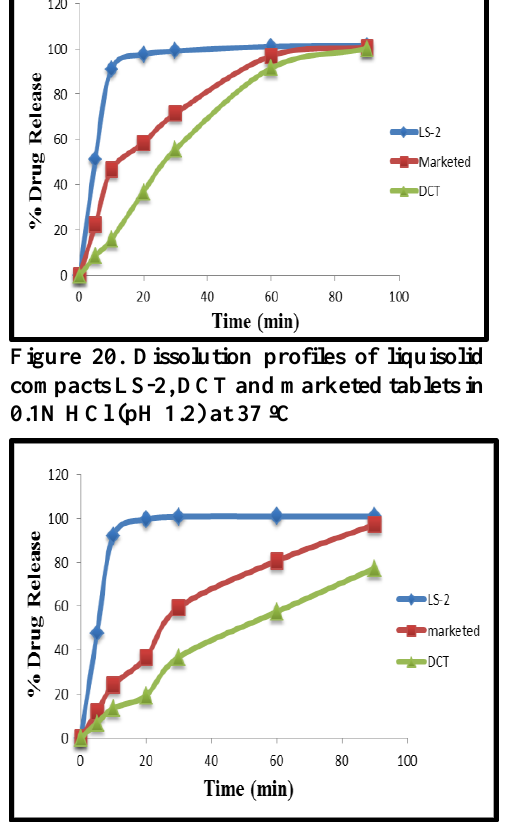
Figure 21. Dissolution profiles of liquisolid compacts LS-2, DCT and marketed tablets in Phosphate buffer (pH 6.8) with 1% SLS at